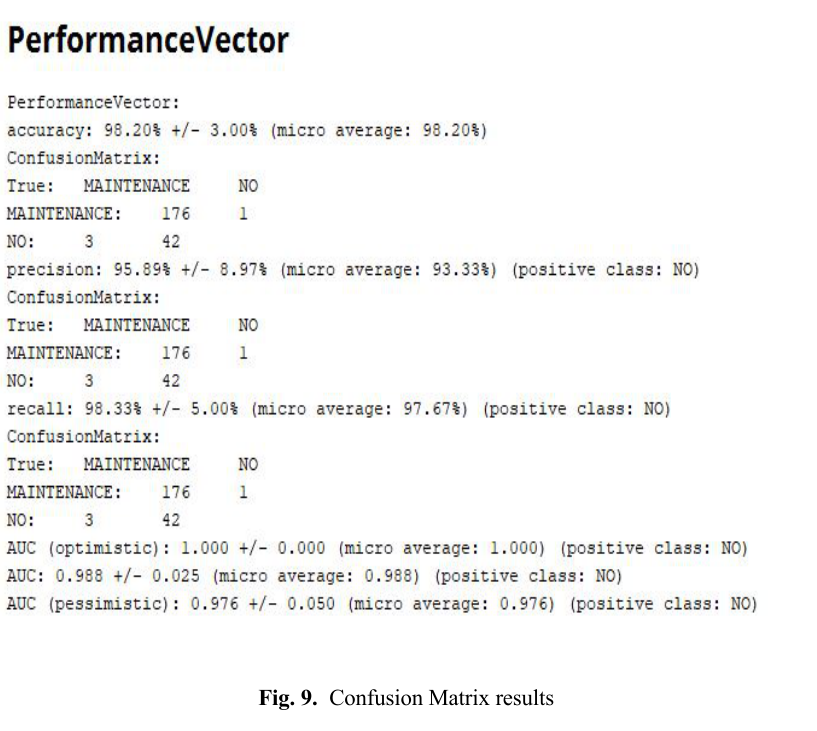
Fig. 9. Confusion Matrix